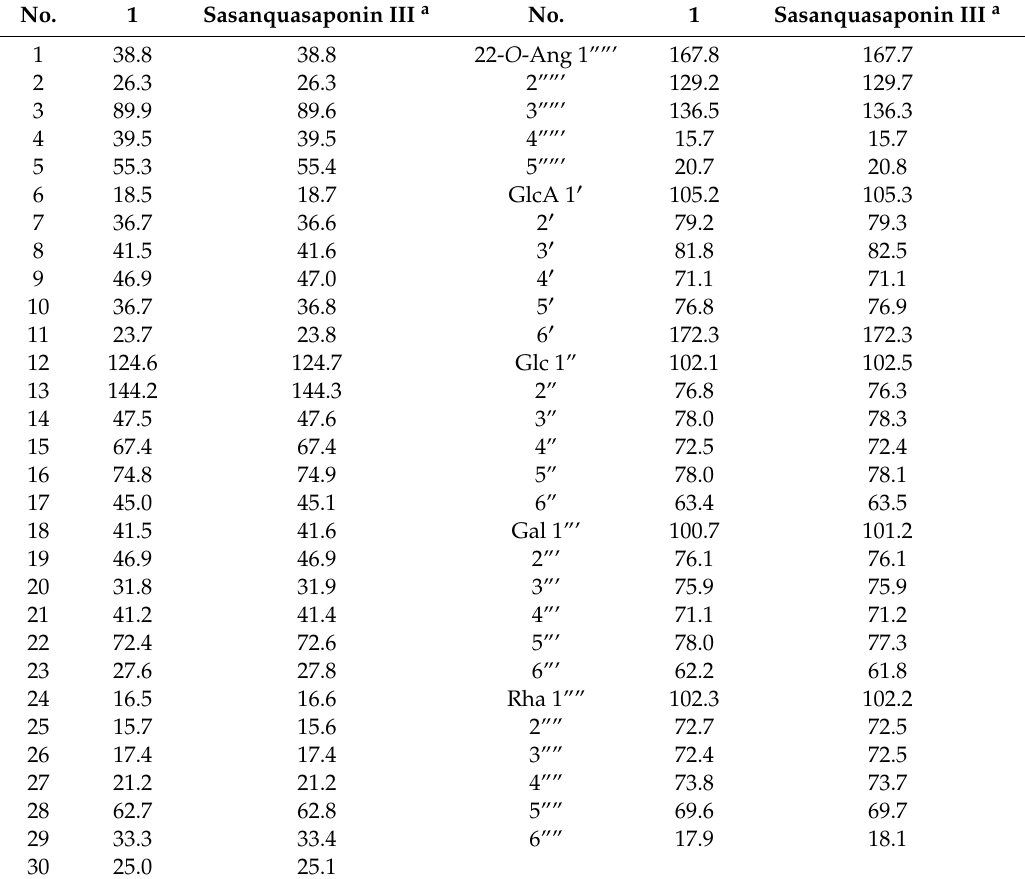
Table 2. 13 C NMR data of compound 1 and sasanquasaponin III (C 5 D 5 N, ppm). No.